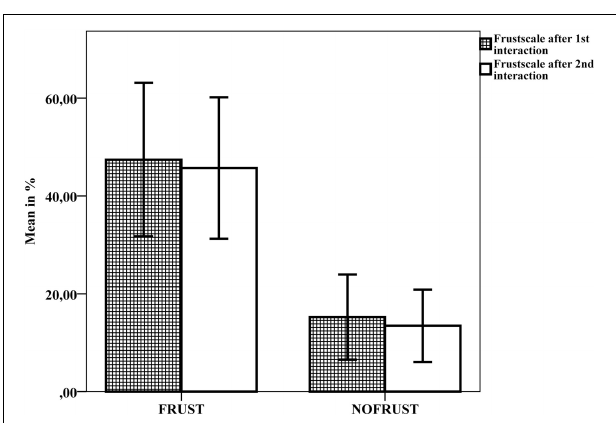
FIGURE 4 | Results of the frustration scales of the NASA-TLX questionnaire after the first (T2) and second (T4) interaction task, mean values and 95% confidence